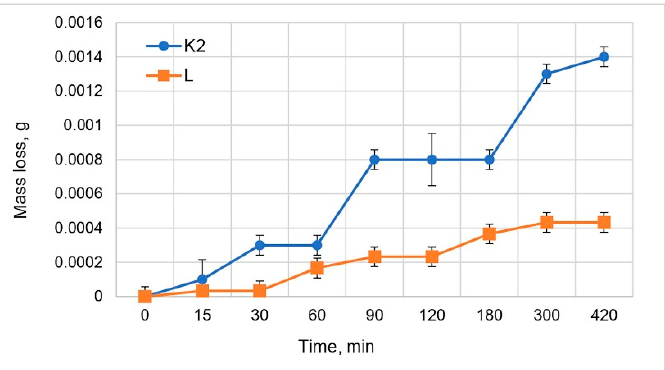
Figure 3. Mass loss during cavitation testing of specimens in the different states, as-cast (L) and quenched (K2), at 885 °C/60 min H 2 O.